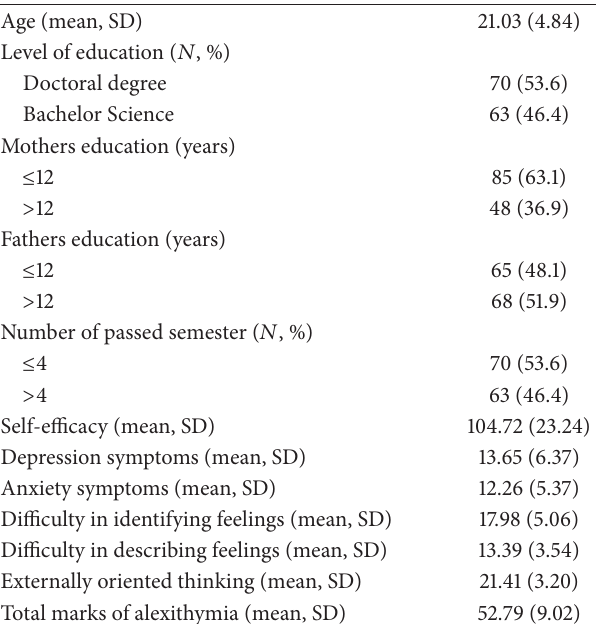
Table 1: Demographic characteristics and psychological variable of the sample